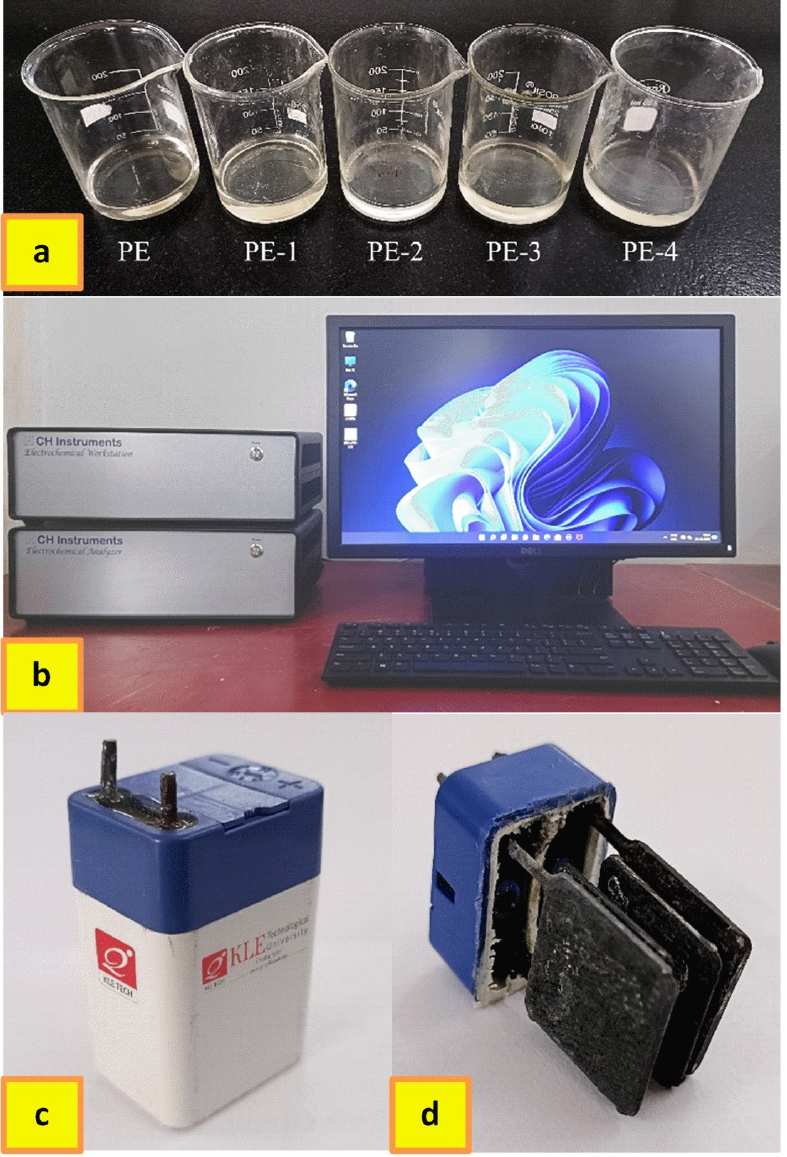
Figure 13. Photo image of ( a ) developed polymer gel electrolytes, ( b ) electrochemical workstation, ( c ) sealed prototype battery, ( d ) cross-section view of the battery showing electrodes.